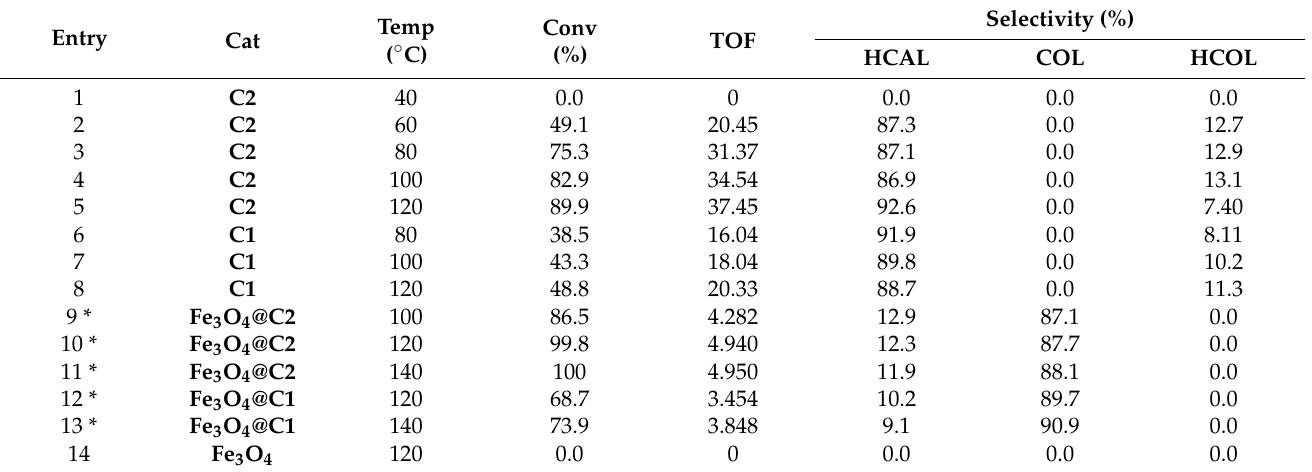
Table 2. Catalytic evaluation of the catalysts for transfer hydrogenation of cinnamaldehyde at varying temperature using all the